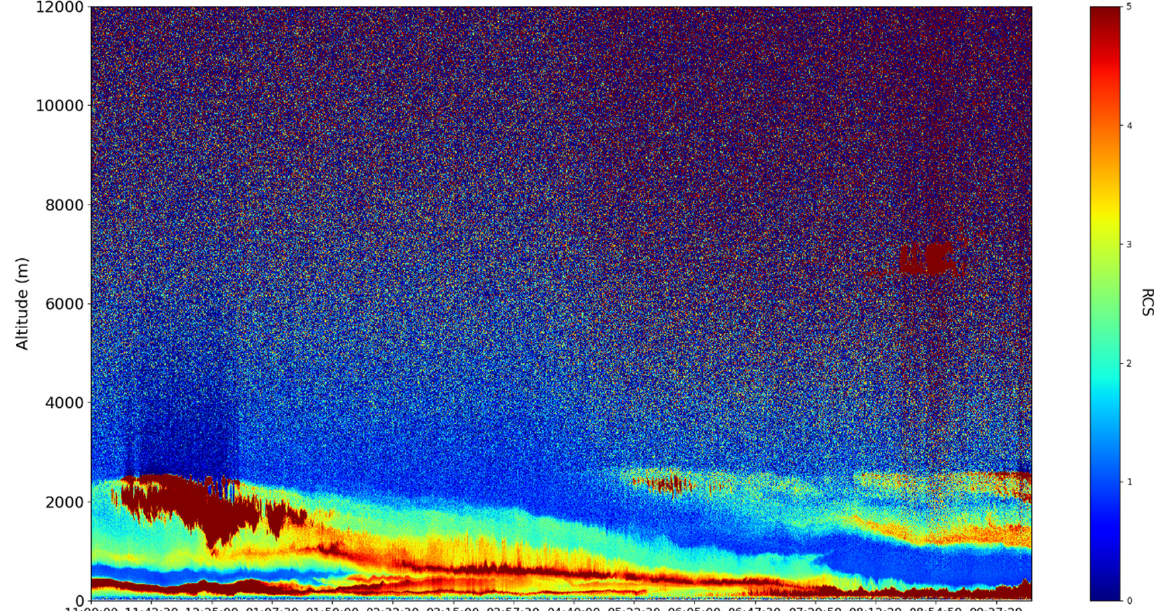
Figure 7. RCS timeseries, λ = 1064 nm , Gala ț i, Romania, 22 December 2021.